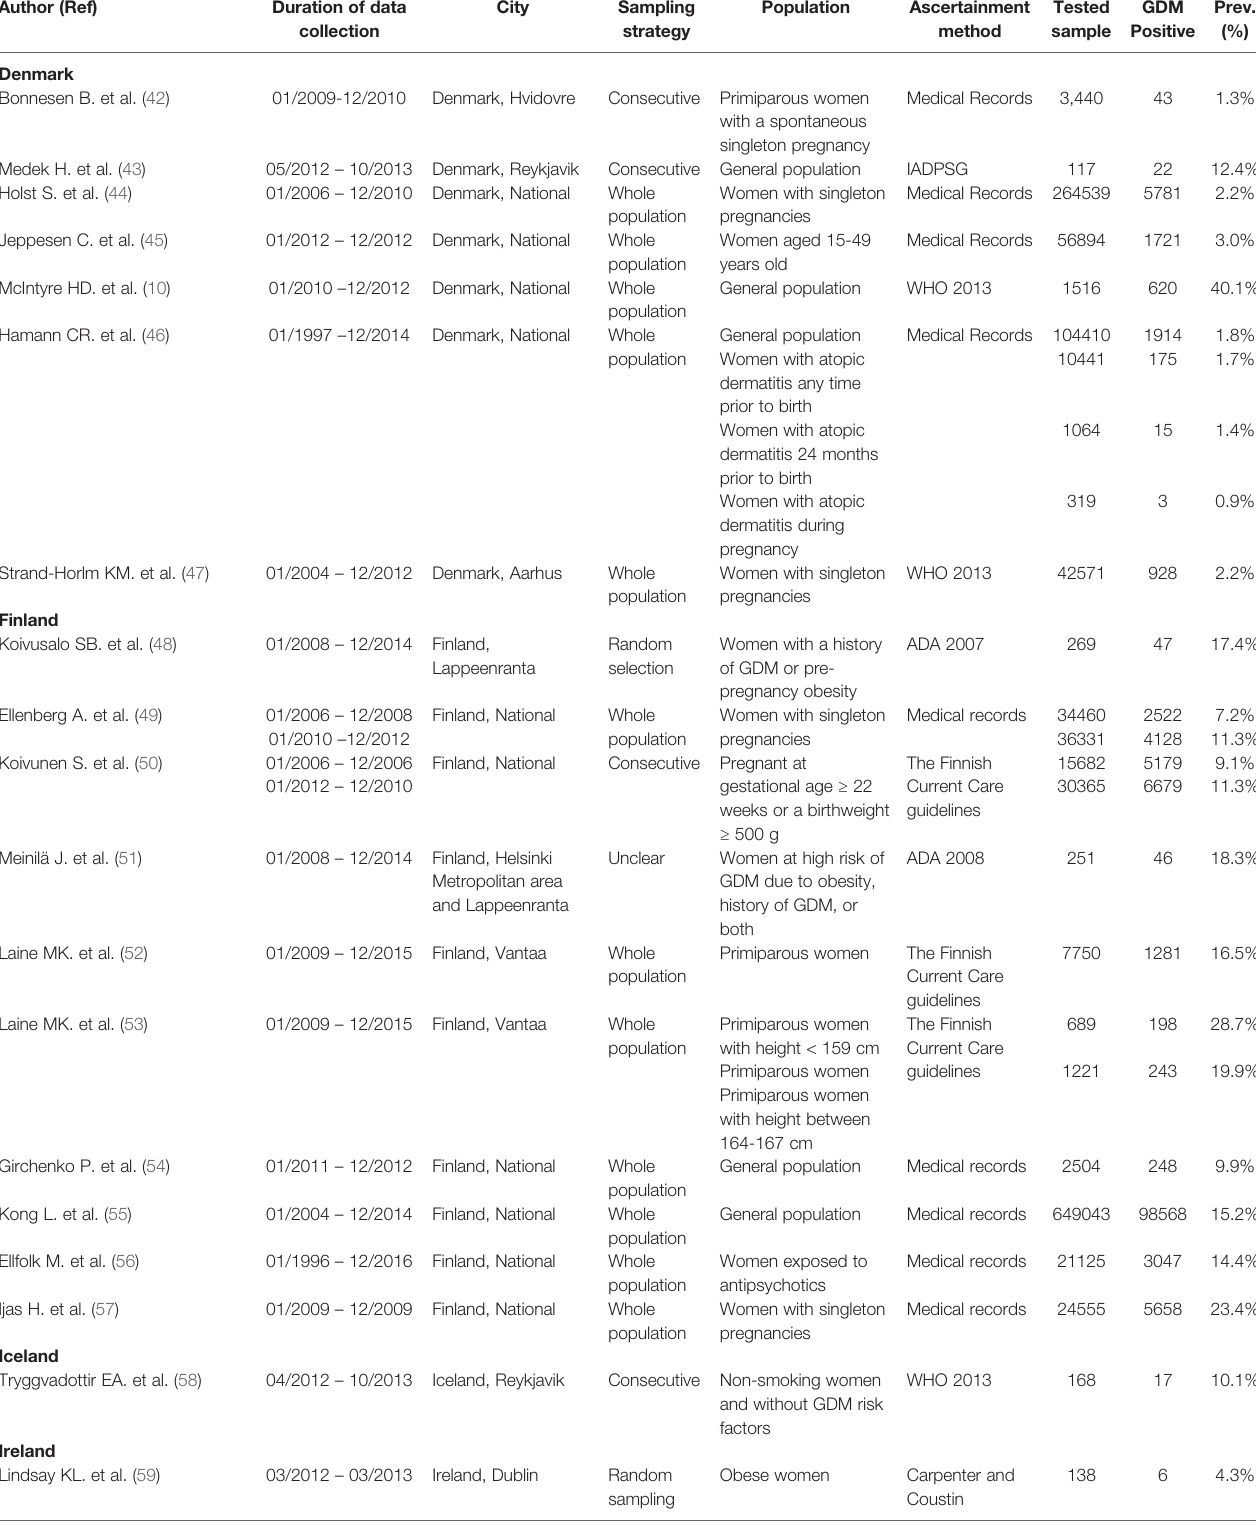
TABLE 2 | Baseline studies characteristics from Northern